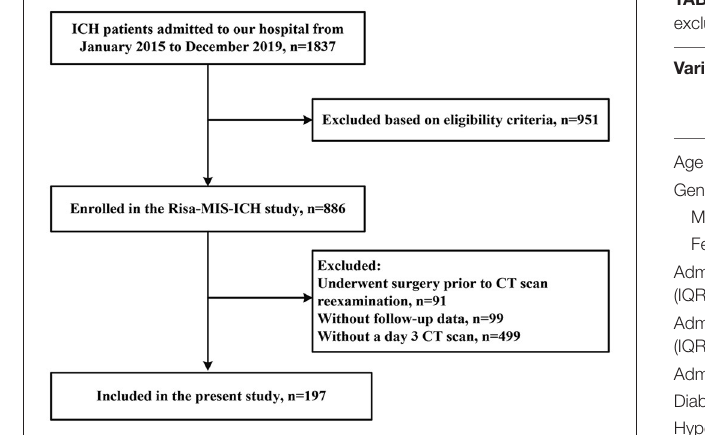
FIGURE 1 | Flow chart of patient selection.